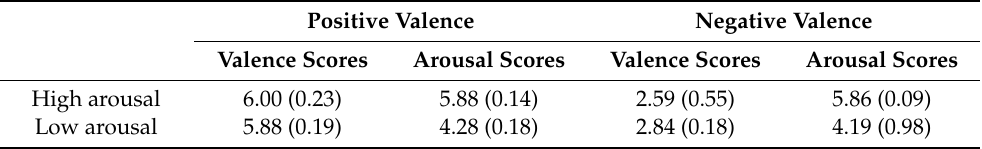
Table 1. Means and standard deviations of valence and arousal scores as a function of valence and arousal.